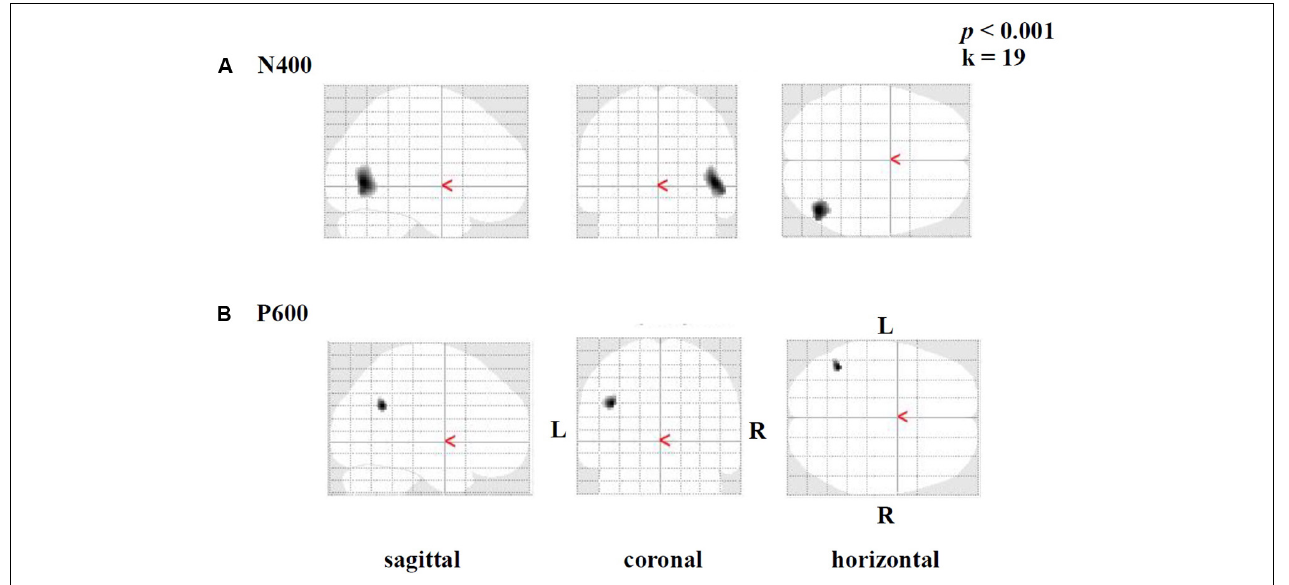
FIGURE 7 | Statistical parametric maps (SPMs) reflecting correlations between relative increases of perfusion during the speech-discrimination task (semantic-anomaly paradigm) and the (A) N400 and the (B) P600 amplitudes, respectively. SPMs are shown as glass brain images. Note the predominant correlations in the temporal cortex (BA 37, A ) and the parietal–occipital areas (in B ).